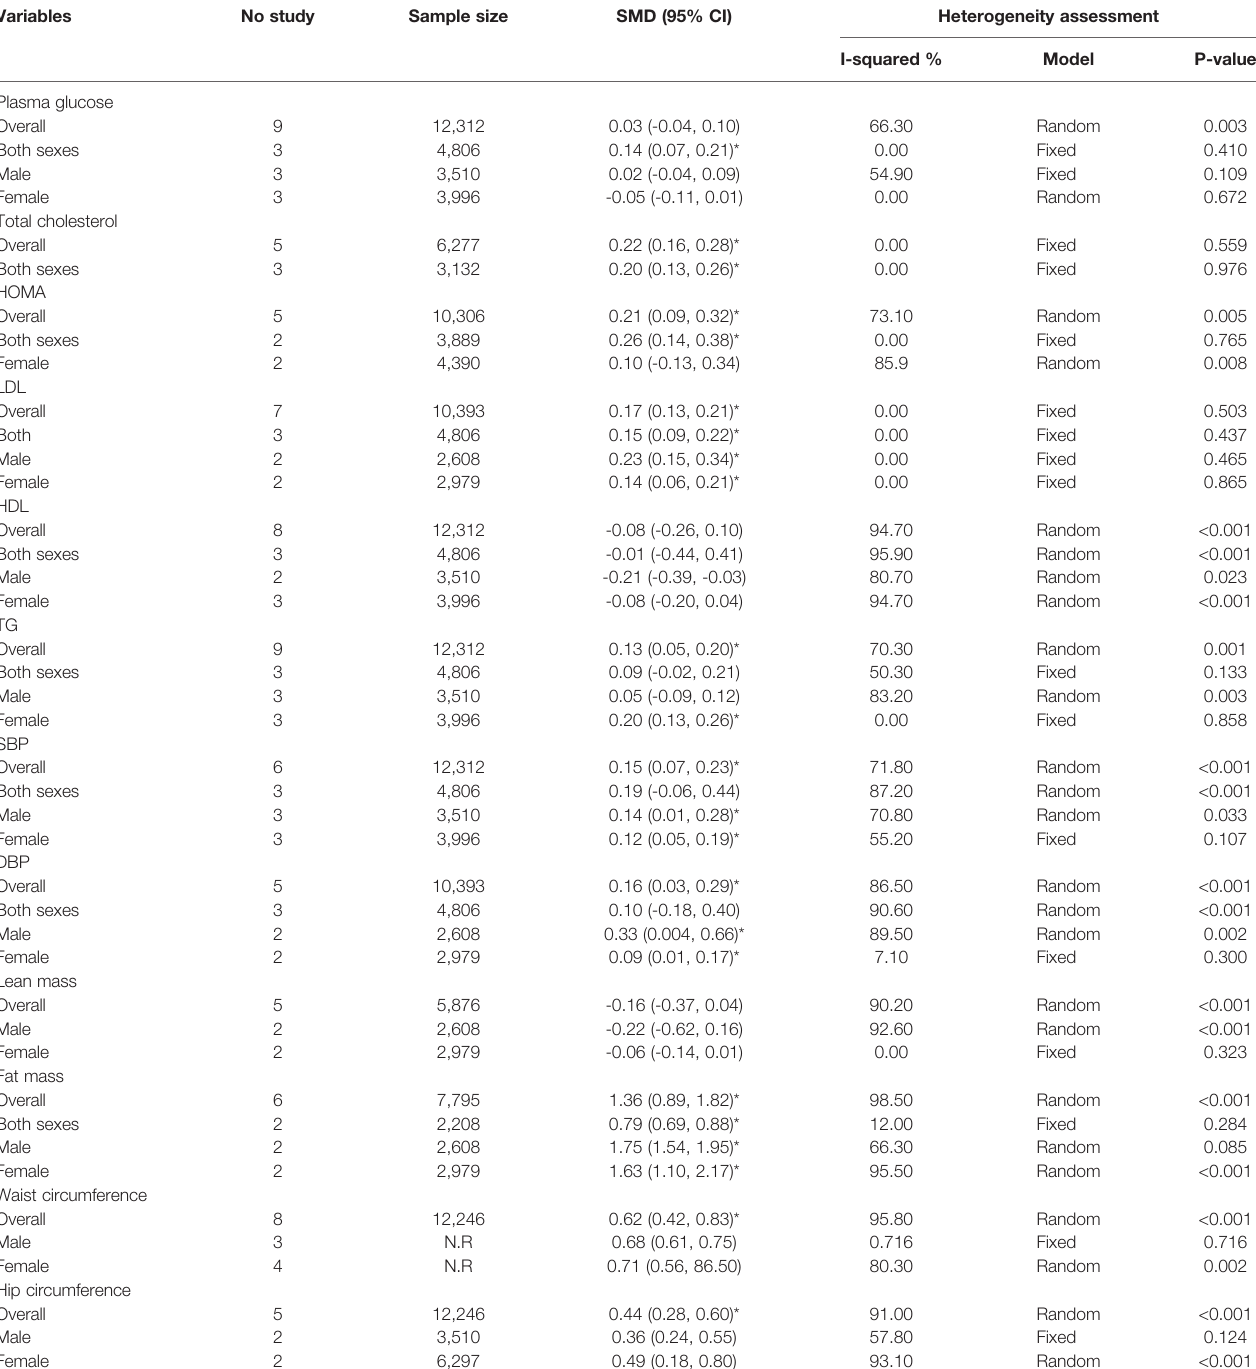
TABLE 5 | Strati fi ed meta-analysis of association between NWO with mean of CMRFs according to